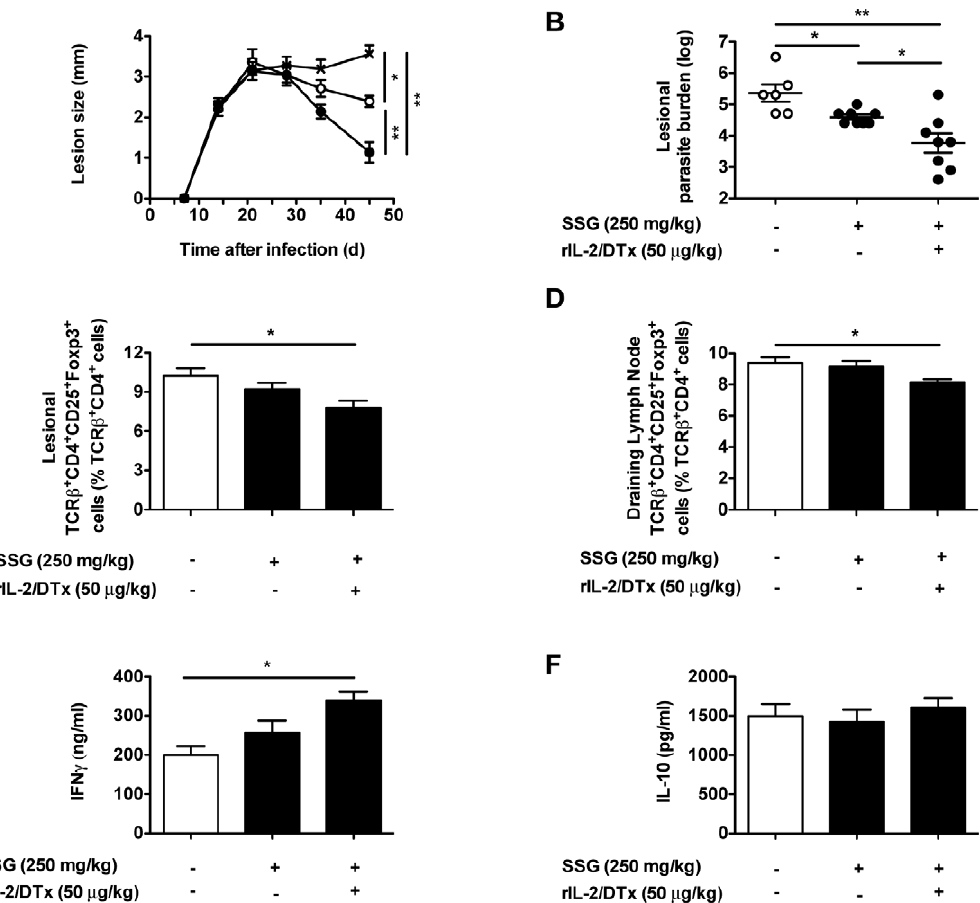
Figure 4. Enhanced resolution of infection with combined therapy correlates with amplification of the effector immune response. C57BL/6 mice were infected as in Figure 2; treatment was begun 30 d after infection. ( A ) Lesion size. Mice were treated: (1) daily for 10 d with SSG (250 mg/kg; open circles); (2) daily for 10 d with SSG (250 mg/kg) plus three times at 5 d intervals with rIL-2/DTx (50 m g/kg; filled circles); or (3) with normal saline (per route and schedule for 10 d SSG plus 3 doses of rIL-2/DTx; crossed symbols); harvested 45 d after infection. ( B ) Lesional parasite burden; ( C ) Lesional T reg percentage; ( D ) T reg percentage in draining lymph nodes; Antigen-specific ( E ) IFN- c and ( F ) IL-10 secretion by leukocytes isolated from lymph nodes draining lesional sites and cultured in presence of soluble Leishmania antigen (quantified by ELISA); Data represent means + / 2 SE of 6–8 animals/group in a single experiment (with individual data points shown for parasite burden); ( A ) MANOVA P , 0.05; ( A–F ) statistical analysis on data obtained 45 d after infection; ANOVA P , 0.05; Tukey’s correction; * P , 0.05, ** P ,